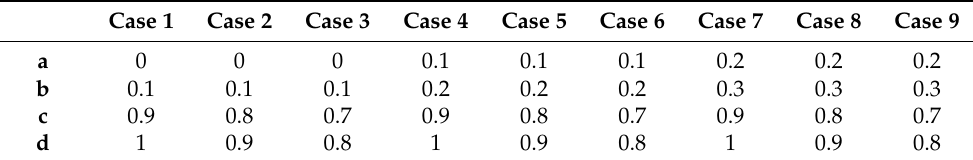
Table 2. Parameters to generate the matrix F of the benchmark